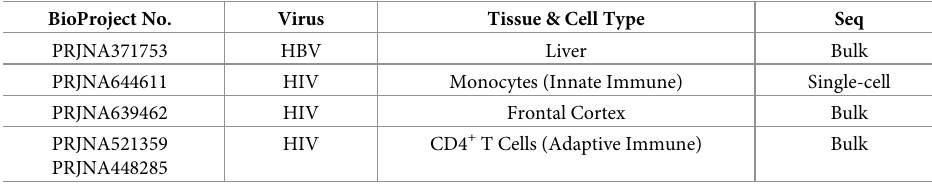
Table 3. Details and BioProject accession number for each analyzed dataset. BioProject